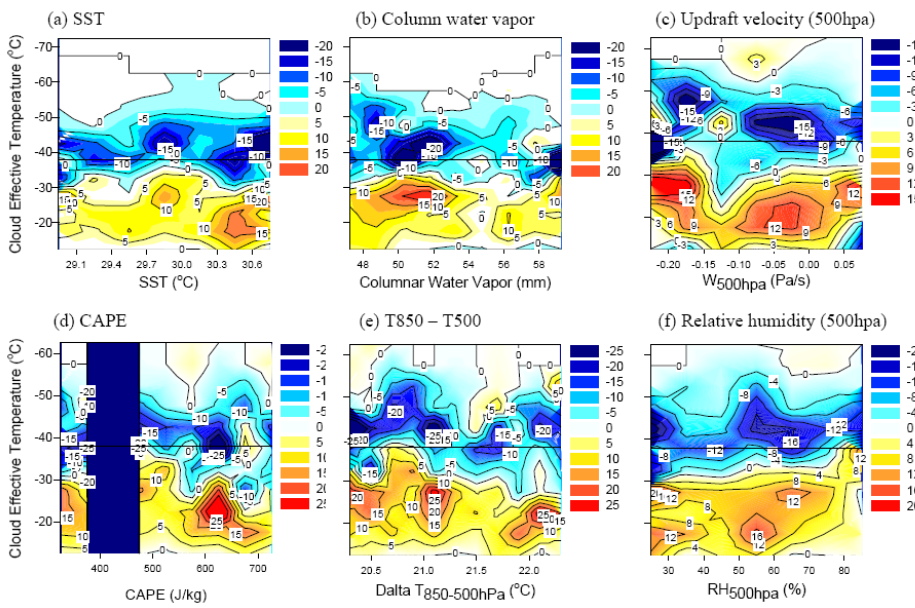
Fig. 3. The difference of probability density functions (PDFs) of ice cloud effective temperature between dust-free and dust-laden conditions with given (a) sea surface temperature; (b) column integrated water vapor; (c) mid-level updraft velocity (500hPa); (d) convection available potential energy; (e) temperature difference between 850 and 500hPa; and (f) mid level relative humidity (500hPa).